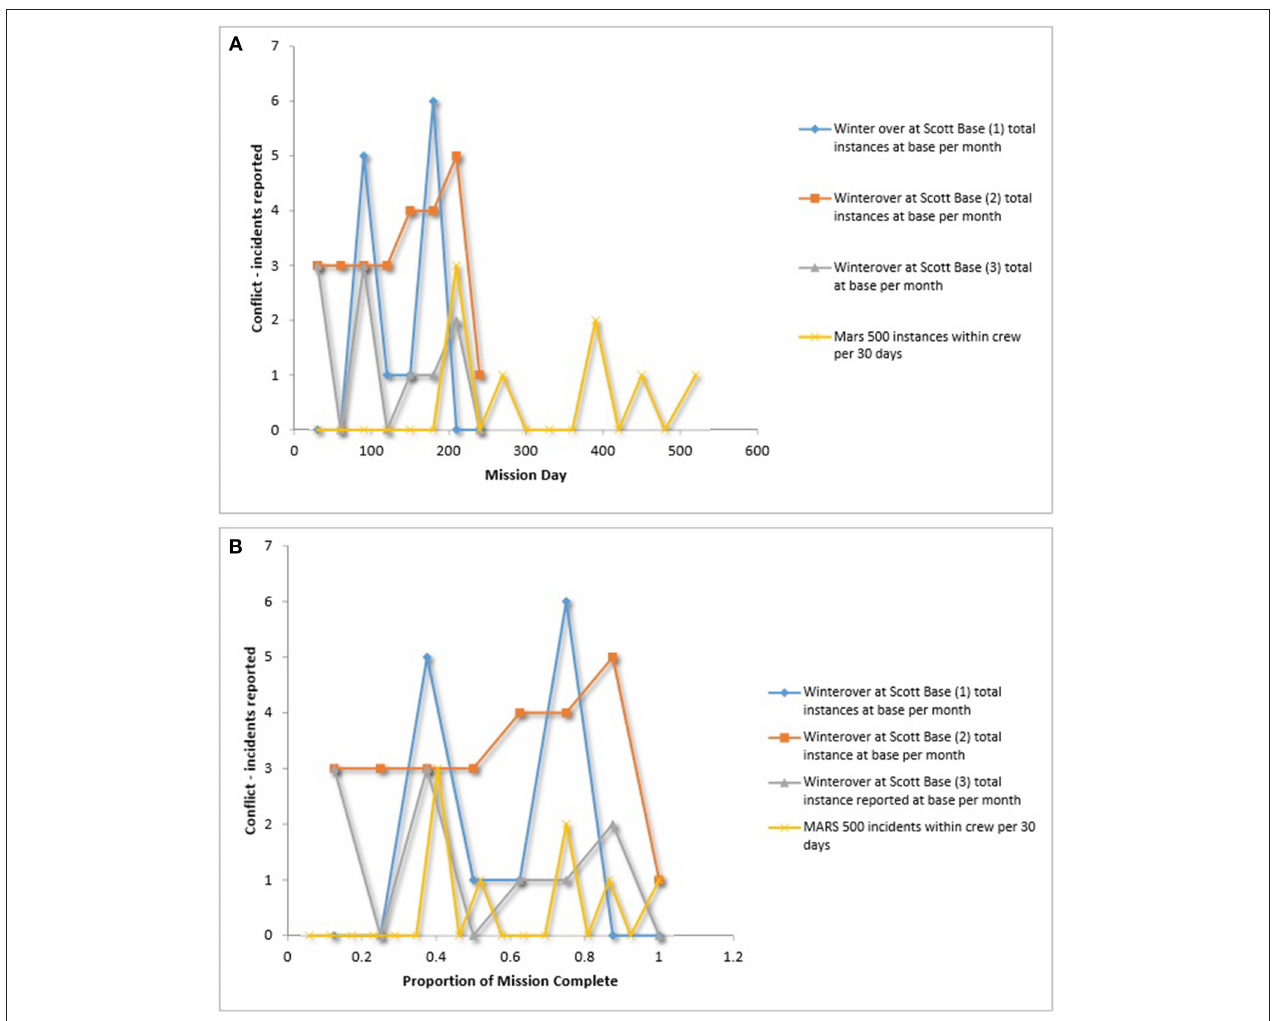
FIGURE 5 | (A) Team conflict over time. (B) Team conflict over relative time. Steel (2001), Basner et al. (2014).